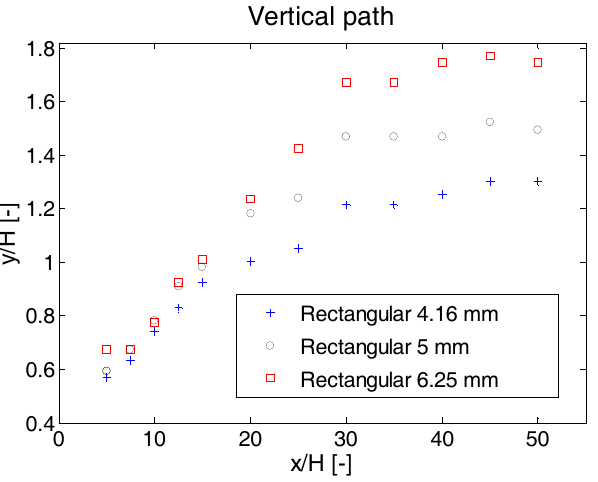
Figure 14. The development of the vortex center in the vertical direction.